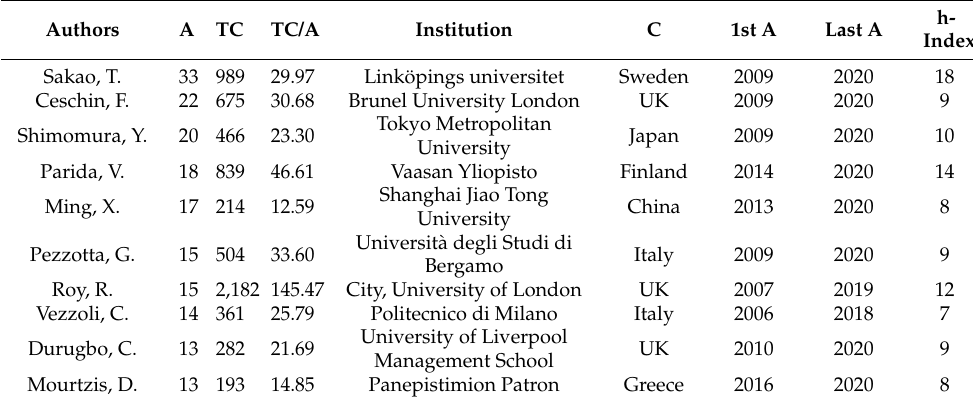
Table 3. The most prolific authors in PSS research during